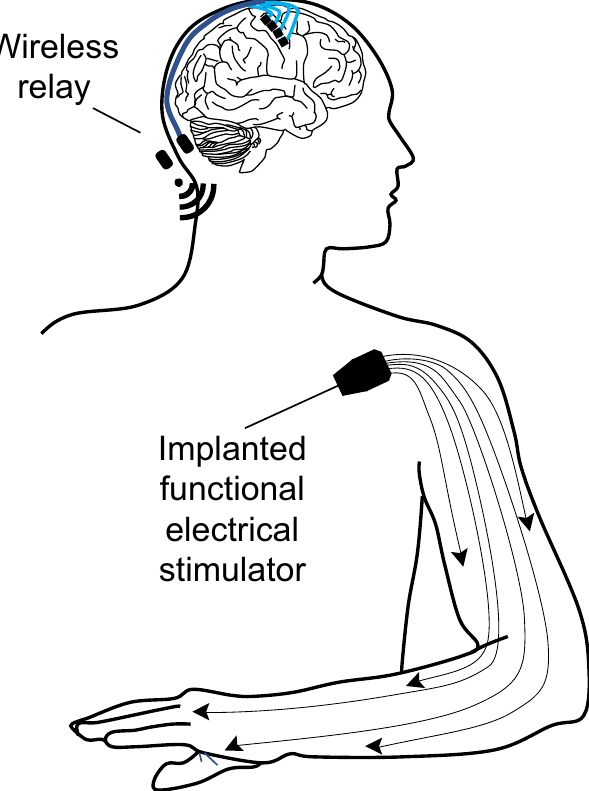
Fig. 8 A hypothetical fully implantable upper extremity movement restoration system for people with hemiparesis from chronic stroke. Sensors implanted within or adjacent to perilesional motor cortices relay signals wirelessly to microprocessors that decode motor intent that in turn triggers a functional electrical stimulation system implanted within the paretic limb to restore voluntary motor